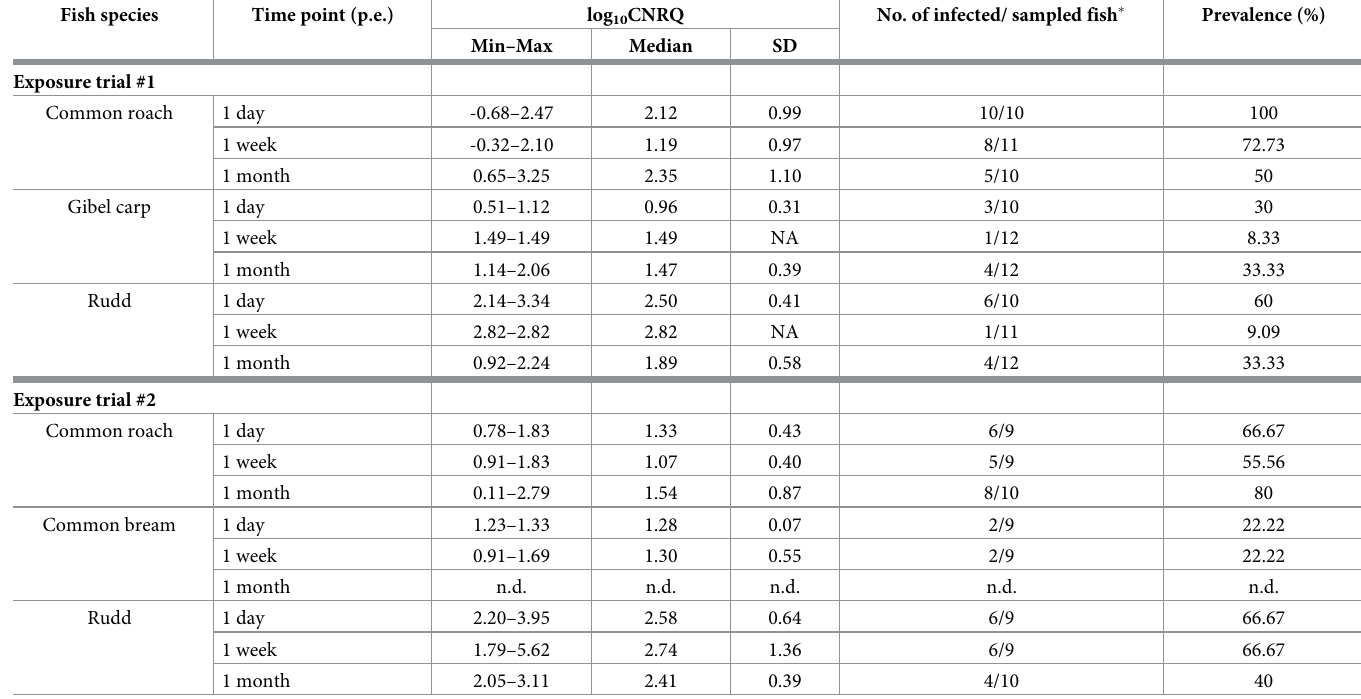
Table 3. Descriptive statistics of Myxoboluspseudodispar infection in the blood of cyprinids. Fish species